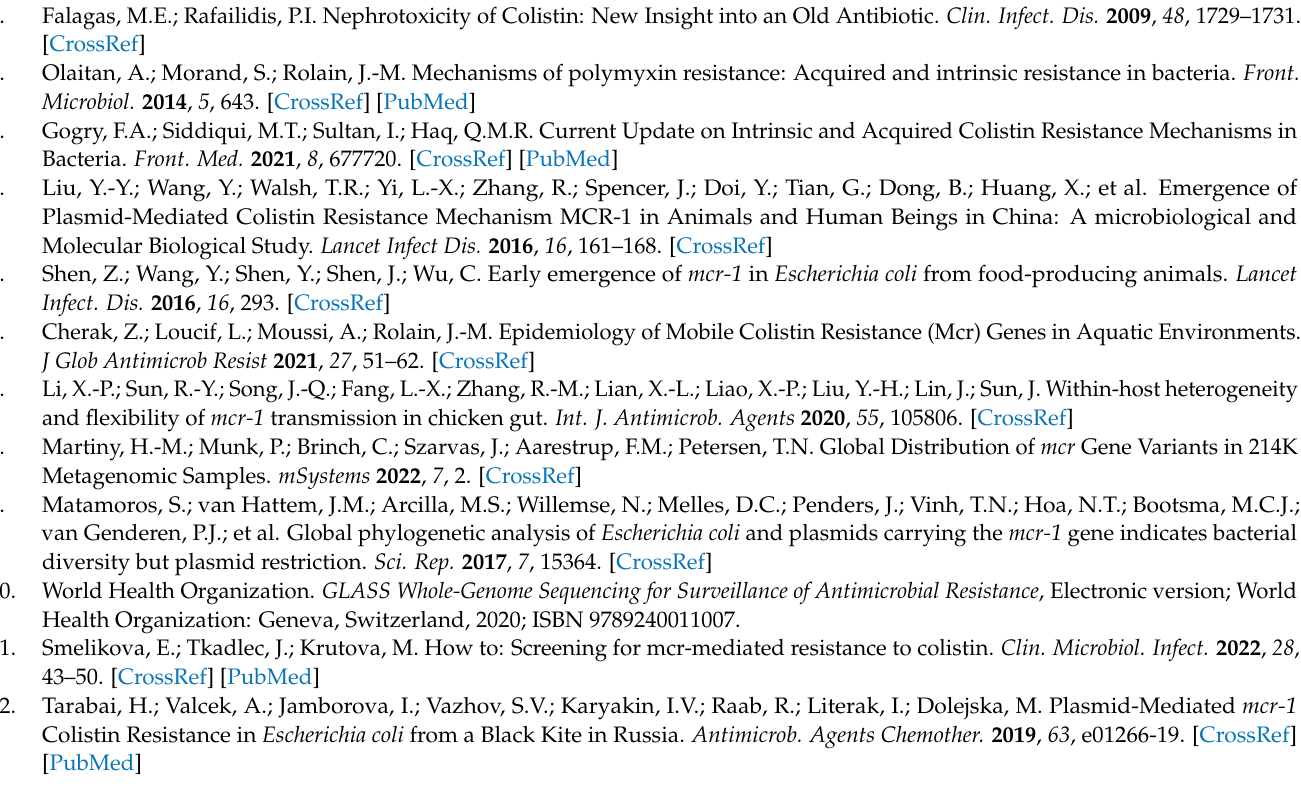
statistics. Table S3. MinION sequencing read statistics and hybrid assembly summary. Table S4. Features of hybrid assembly contigs. Table S5. Summary of MinION reads spanning the entire tandem repeat region in IncFIB(K) plasmid of K. pneumoniae kp_87441. Table S6. Summary of MinION reads spanning the region with two copies of bla CTX-M-15 gene in IncM2 plasmid of E. coli ec_92380. Figure kp_87441. Figure S2. Structure of repeat region in IncM2 plasmid of E. coli